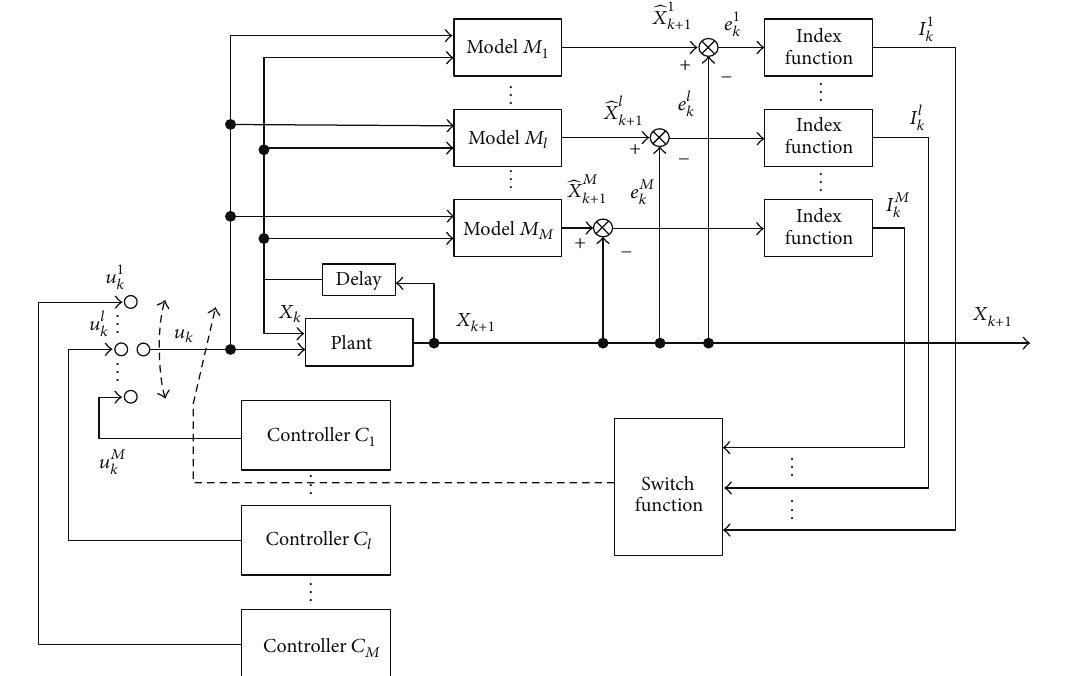
Figure 1: Structure of multiple model ADP with accurate